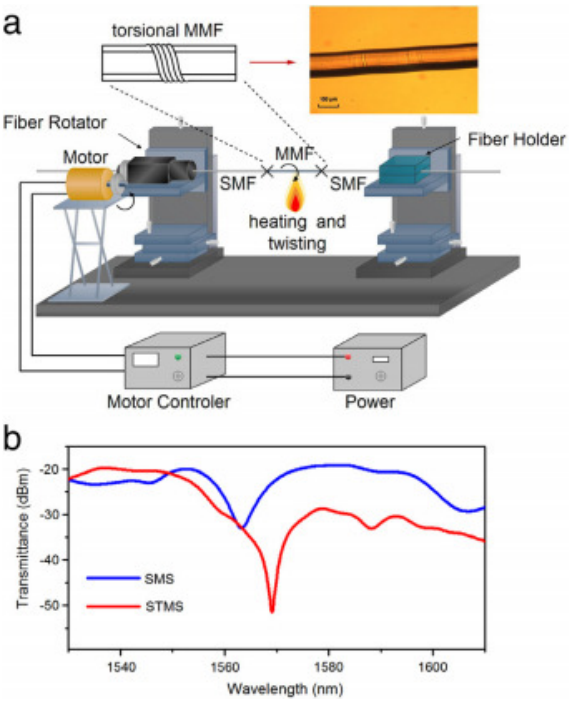
Figure 4. ( a ) Equipment and process of fabricating single mode–twisted-multimode–single mode fiber structure; ( b ) the transmittance spectrum of single mode–multimode–single mode fiber structure (SMS) and single mode–twisted-multimode–single mode fiber structure (STMS), respectively [62]. Reprinted with permission from Ref. [62]. Copyright 2017 Elsvier Science and Technology